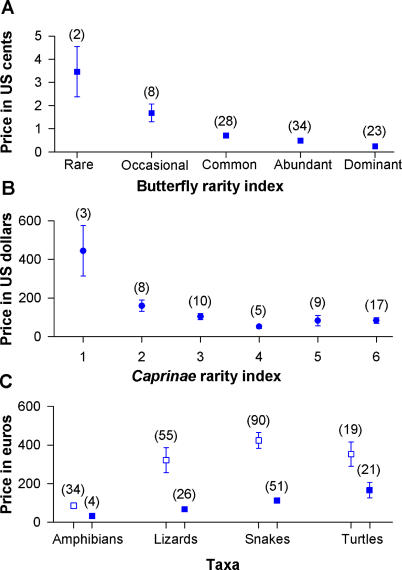
Empirical Examples of Activities where the Price of Species Is Related to Rarity or Perceived Rarity(A) Prices of collectible butterflies in Papua New Guinea (modified from [9]).(B) Hunting trophy prices of 57 Caprinae taxa.(C) Selling prices of exotic pet species according to CITES status. Species that have a CITES status (open squares) are more expensive than species with no CITES status (solid squares).Prices were standardized by dividing by (A) male wingspan, (B) trophy size, and (C) adult weight (see text for details).Vertical bars: standard error; sample size in parentheses.